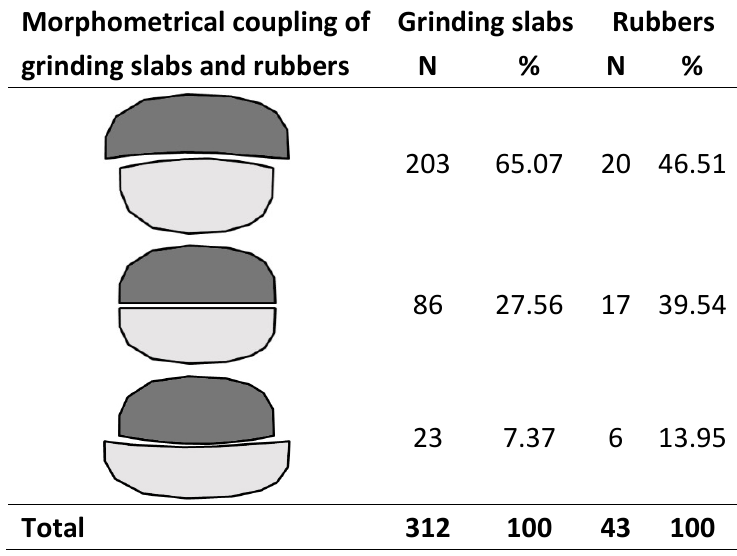
Table 1. Morphology of the transverse profile of the active surfaces of grinding slabs and potential stone rubbers from well dated El Argar contexts of Fuente Álamo, Gatas, Lorca, Barranco de la Viuda, Los Cipreses and Cerro de la